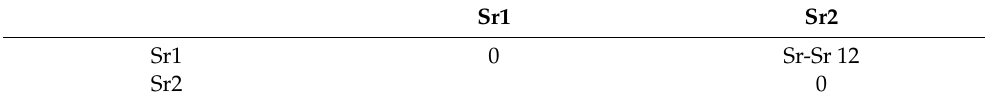
Table A3. Configurational Matrix (mutual interatomic distances in NN, as in Table A2) for x = 0.125.